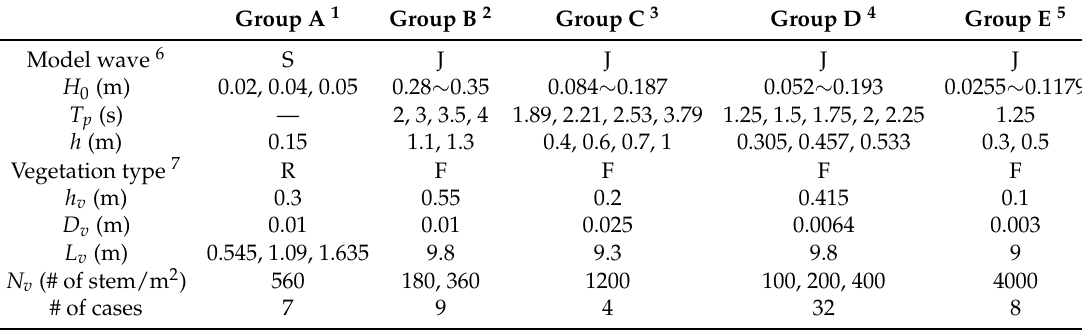
Table 1. Experimental conditions of the laboratory studies used in the present numerical tests on the modeling of wave damping by